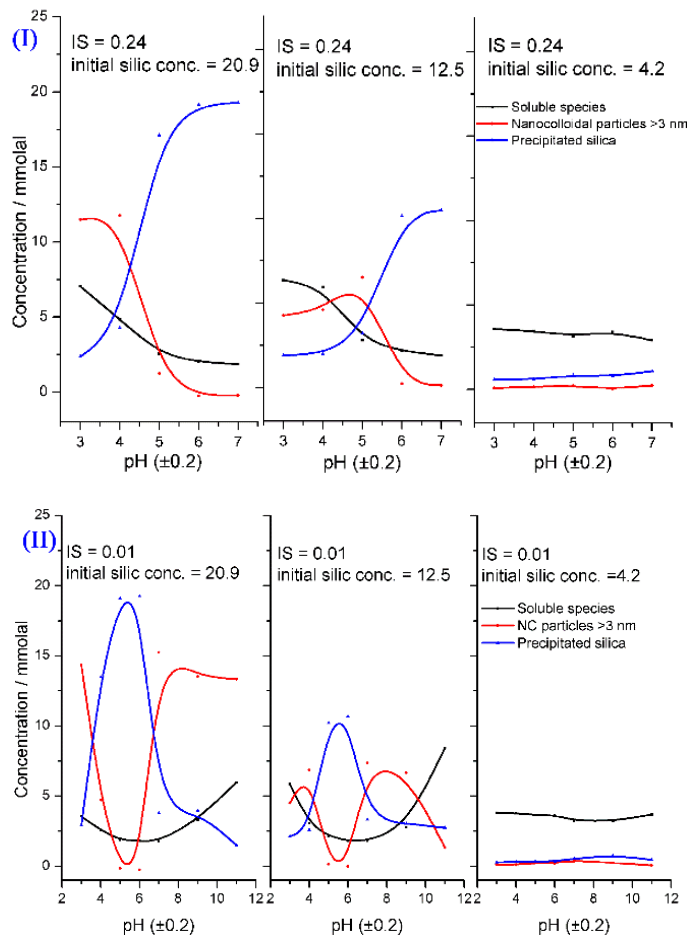
Figure 14. Extracted data represent the silica species as a function of the pH at different concentrations of ( I ) silicic acid and ( II ) IS. Reprinted with permission from [33]. Copyright Elsevier, 2005.